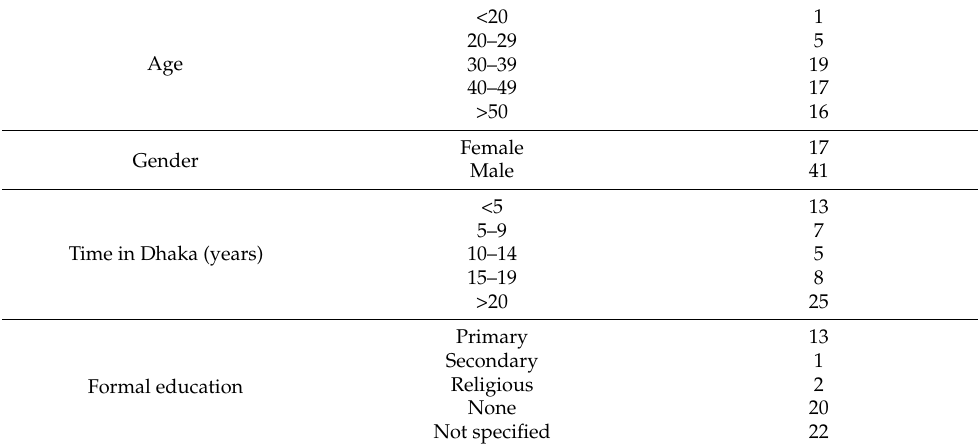
Table 1. Participant demographic information (n: